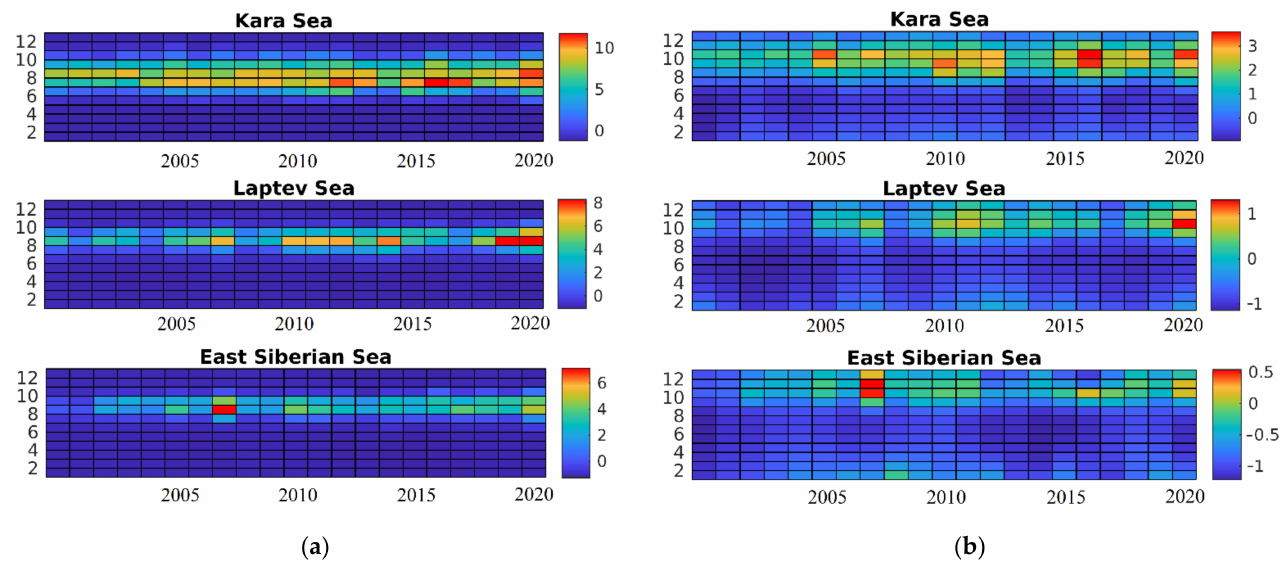
Figure 4. Monthly temperature change (in ◦ C) in the surface ( a ) and bottom layer ( b ) of the Arctic seas. Numerical simulation result.